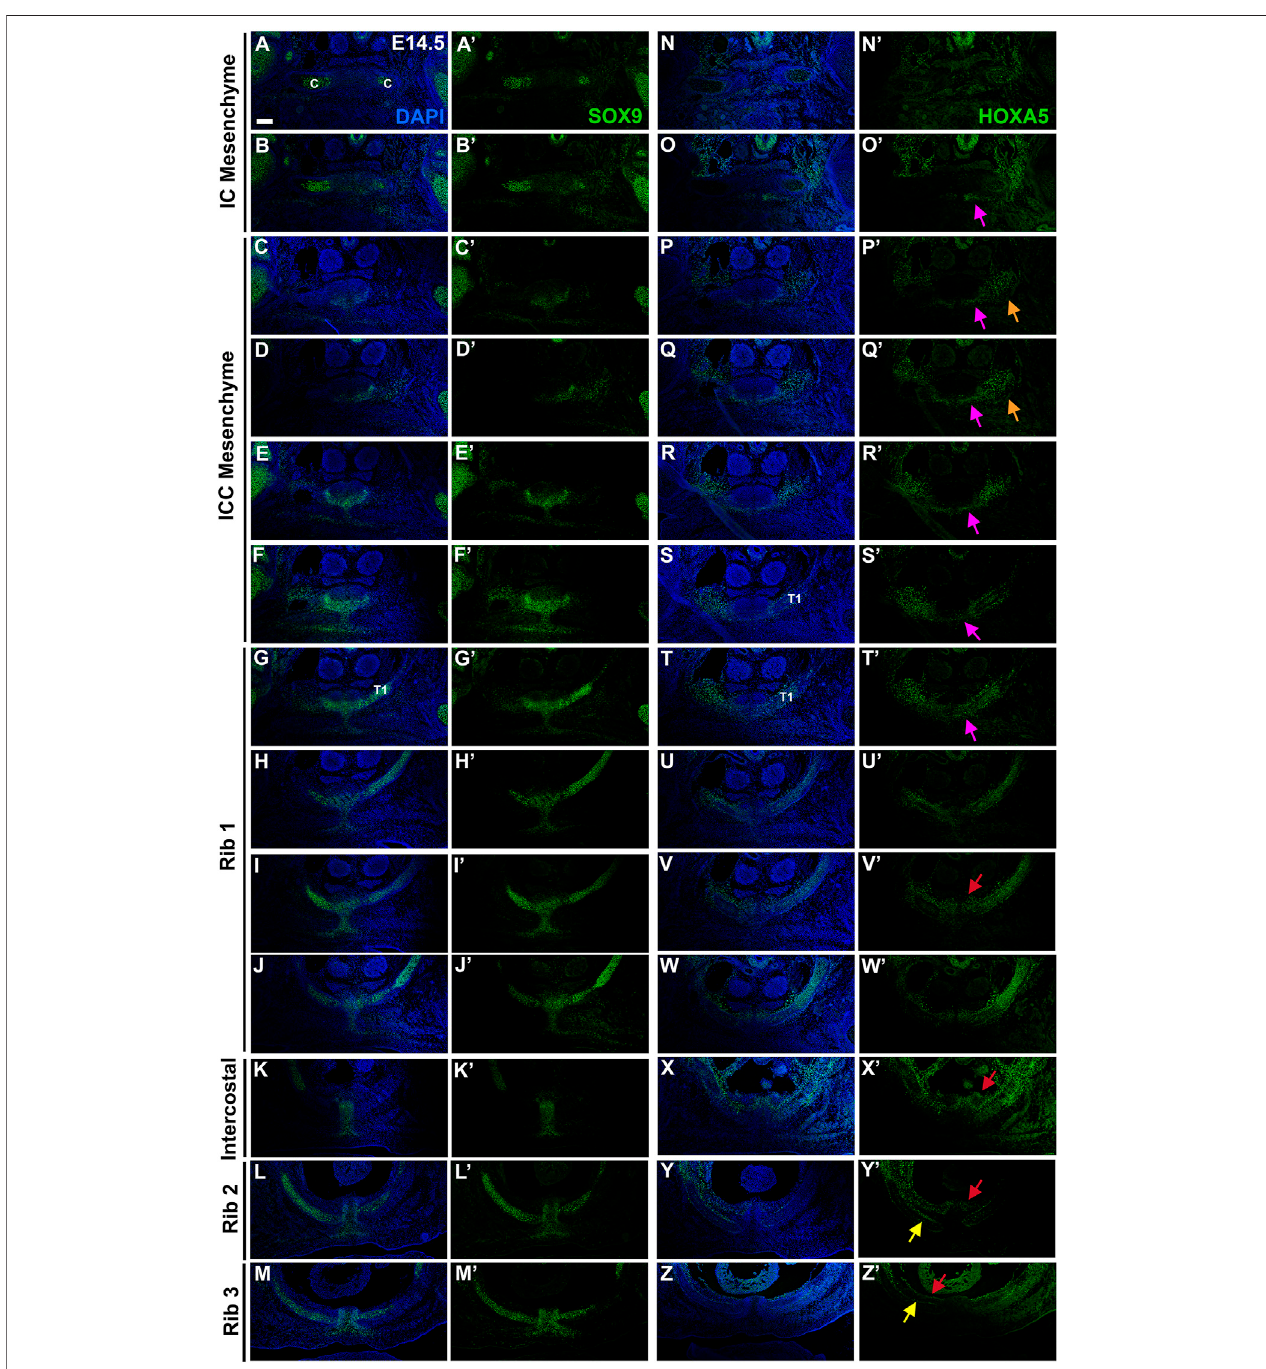
FIGURE 5 | HOXA5 is speci fi cally expressed in ventral elements of the presternum. SOX9 (A – M ′ ) and HOXA5 (N – Z ′ ) expression in alternate sections of a WT E14.5, from the anterior presternum through T1 – T3 attachments, shown with (A – M, N – Z) and without (A 9 – M 9 , N 9 – Z 9 ) DAPI. C, clavicle. Pink arrow in (O ′ – T ′ ) identi fi es expression of HOXA5 in the paired ventral elements of the ICC mesenchyme. Orange arrows in P ′ and Q ′ mark HOXA5 expression lateral to, but continuous with, the presternum. Red arrow in V ′ indicates HOXA5 expression within the sternum as it shifts to a more rounded morphology. Red arrows in X ′ and Y ′ point to a shift in Hoxa5 expression more dorsally, likely marking the connective tissue of an infrahyoid muscles. HOXA5 can also be seen in the perichondrium of ribs 2 and 3 (yellow arrows in Y ′ and Z ′ ), and in the body wall mesothelium (red arrow in Z 9 ). Scale bar: 200 μ M. C, clavicle; IC, interclavicular; ICC, intercostoclavicular; T1, thoracic rib 1.